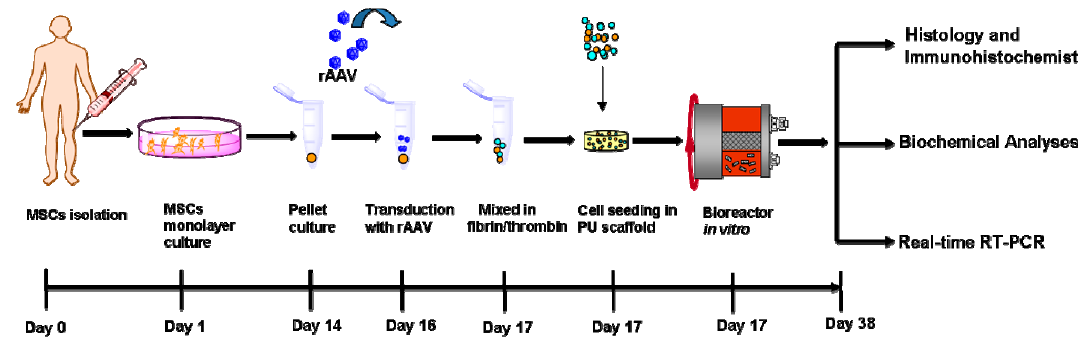
Figure 1. Model system: Human bone marrow-derived mesenchymal stem cells (hMSCs) were isolated from bone marrow aspirates, placed in monolayer culture, released, and hMSC aggregate cultures (2 × 10 5 cells/pellet) were prepared and next transduced with rAAV as described in Materials and Methods. After 24 h, the transduced cells were placed in a fibrin/thrombin mixture and seeded onto fibrin-polyurethane (PU) scaffolds. The constructs were next transferred to rotating bioreactors and maintained in chondrogenic medium in hydrodynamic culture for 21 days for further evaluations as depicted.